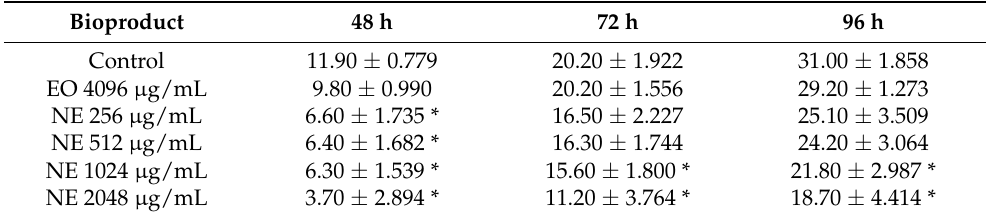
Table 9. Diameter (mm) of A. westerdjikiae colonies in the presence of the EO and the NE at 48, 72, and 96 h.